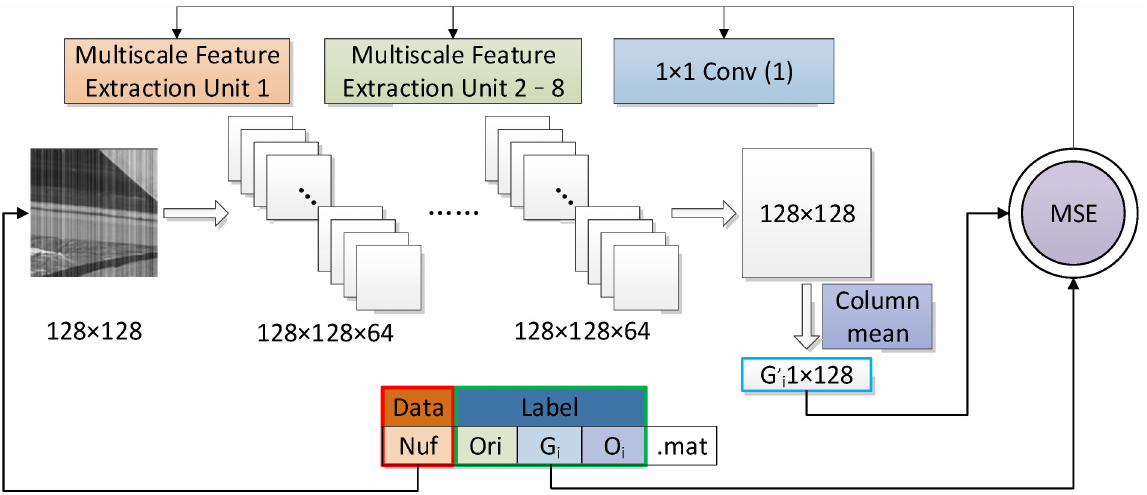
Figure 3. The gain correction sub-network